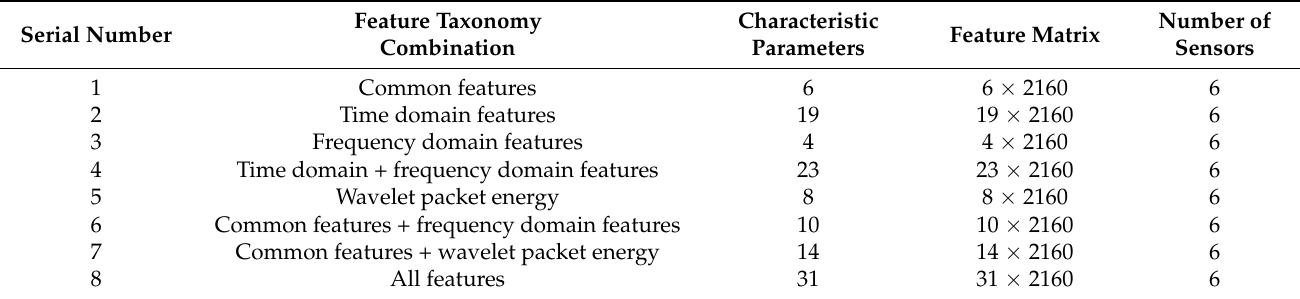
Table 4. The data set of the fault parameter